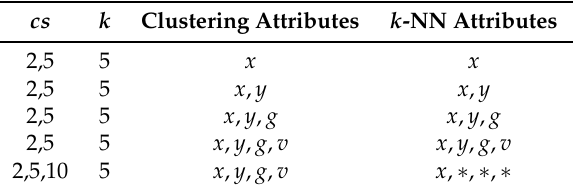
Table 3. Parameters for the first experiment of N = 400 trajectories.